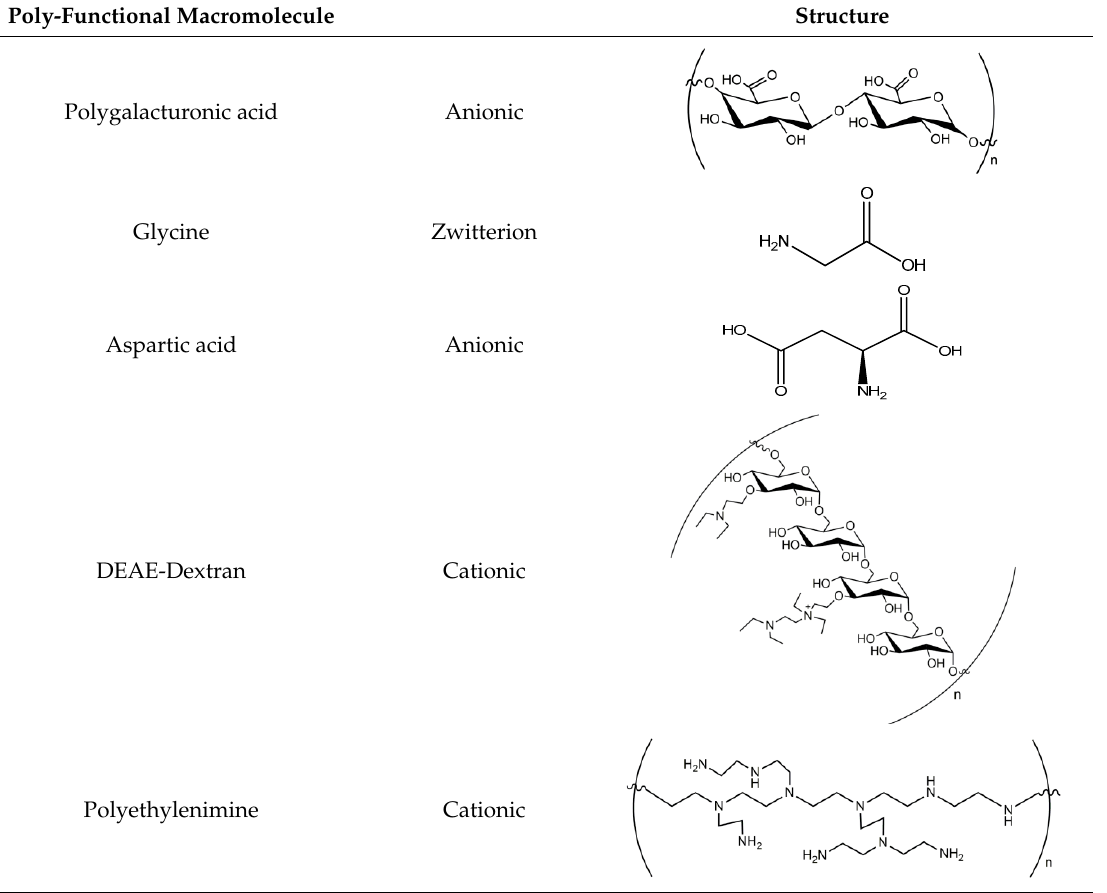
Table 2. Poly-functional macromolecules used in the post-immobilization step and their structural characteristics.